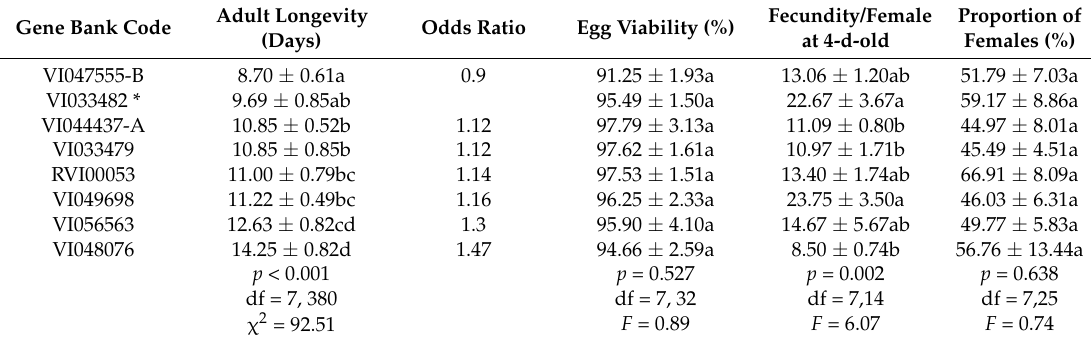
Table 5. Spoladea recurvalis adult longevity, egg viability (%), fecundity and proportion of F 1 females (mean ± SE) on selected amaranth